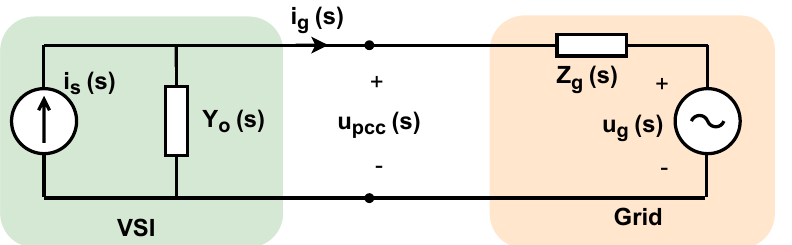
Figure 1. Admittance model of grid–connected